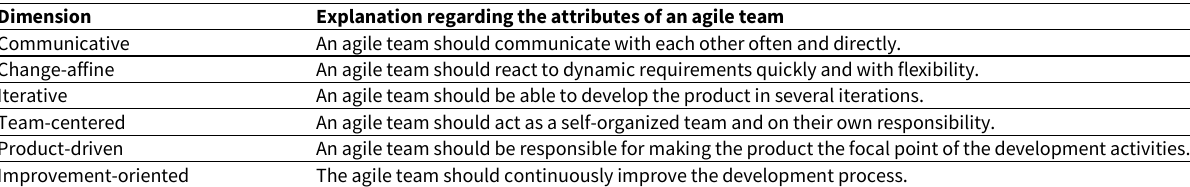
Table 1. Dimensions of the assessment questions Dimension Explanation regarding the attributes of an agile